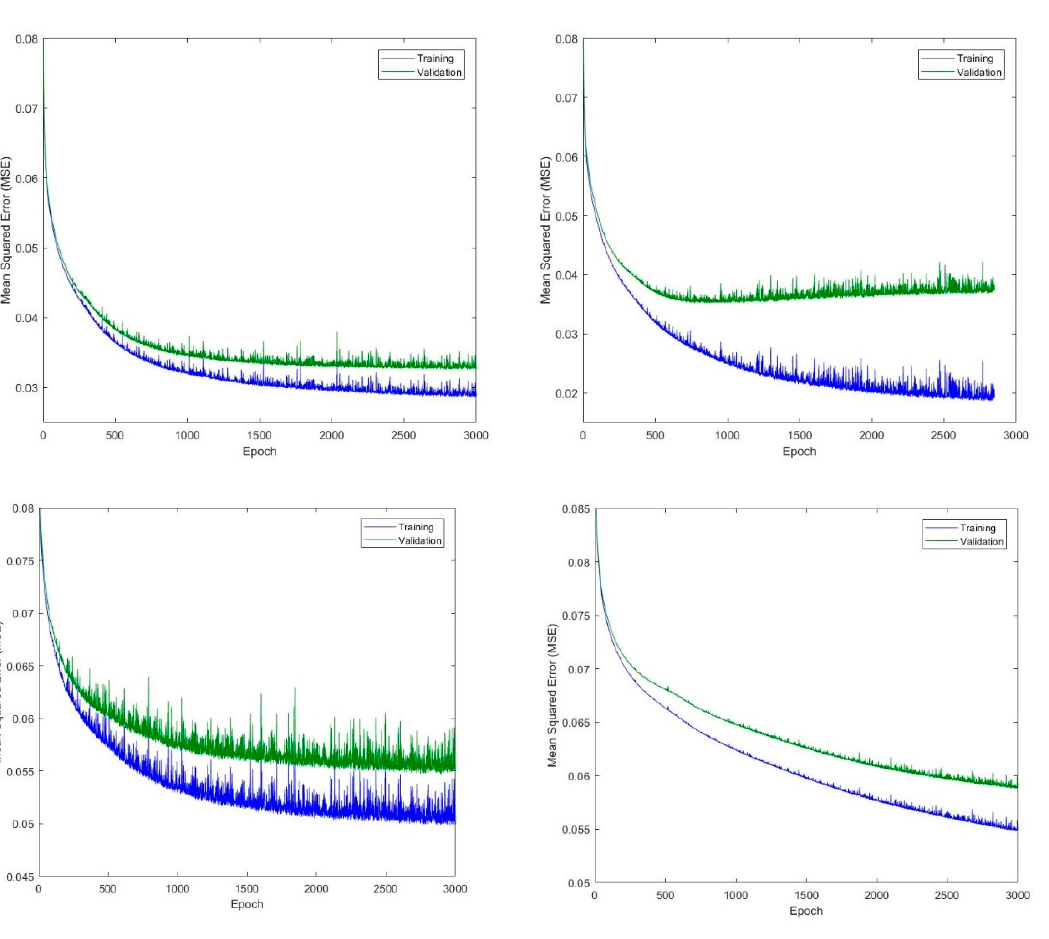
Figure 7. Left side: The visualization of 100 weights in the first layer of the deep belief network (DBN), restricted Boltzmann machines 1 (RBM1), and amplified images are some example of weights. Right side: The visualization of 100 weights in the second layer of DBN, RBM2. The segmentation results are shown in Figures 8–10 on different test axial images.